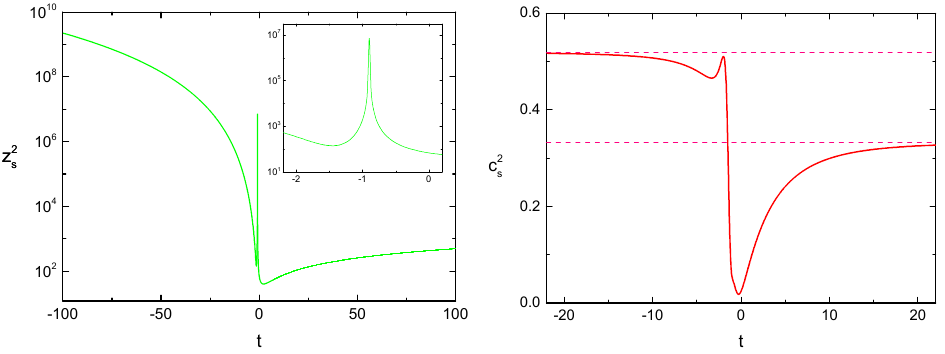
Figure 2 . Dynamics of z 2 by